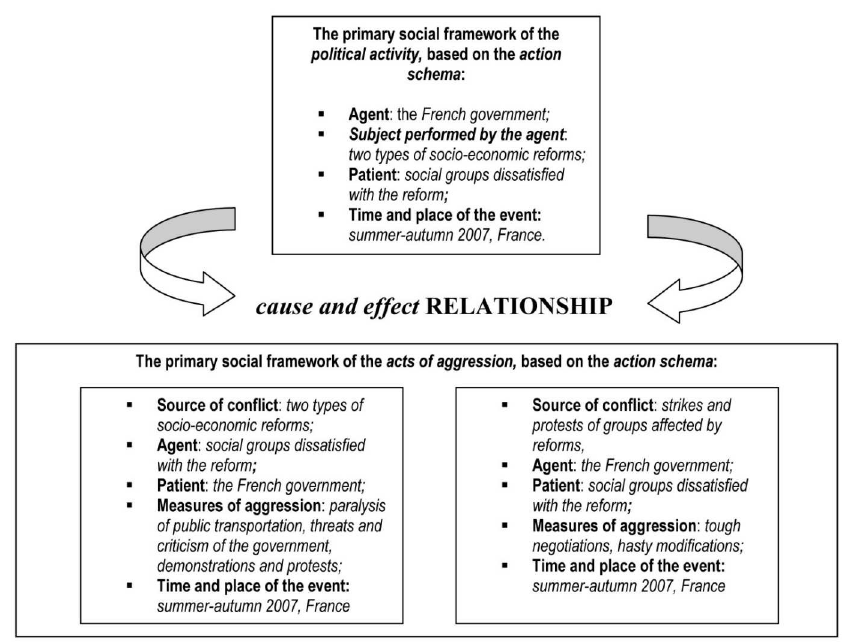
Figure 1. Synthetic model for configuration of frameworks and event